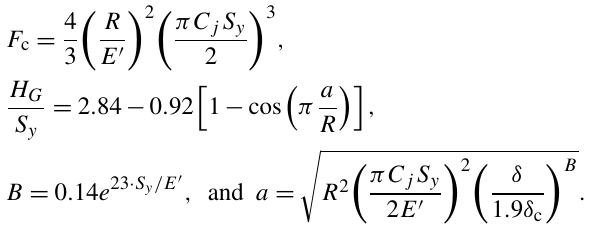
surface is divided into three phases: the elastic, the elasto- plastic, and the restitution phase. In what follows, the instan- taneous contact forces during different impact phases are an-